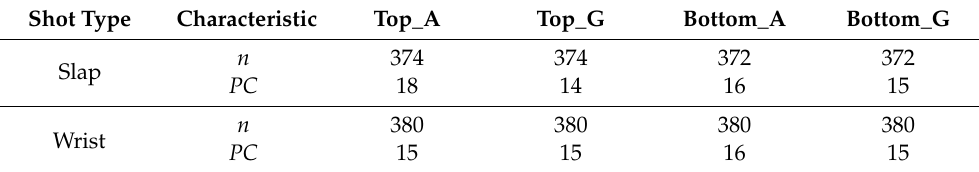
Table 4. Number of trials ( n ) and features (PC) used for each algorithm.